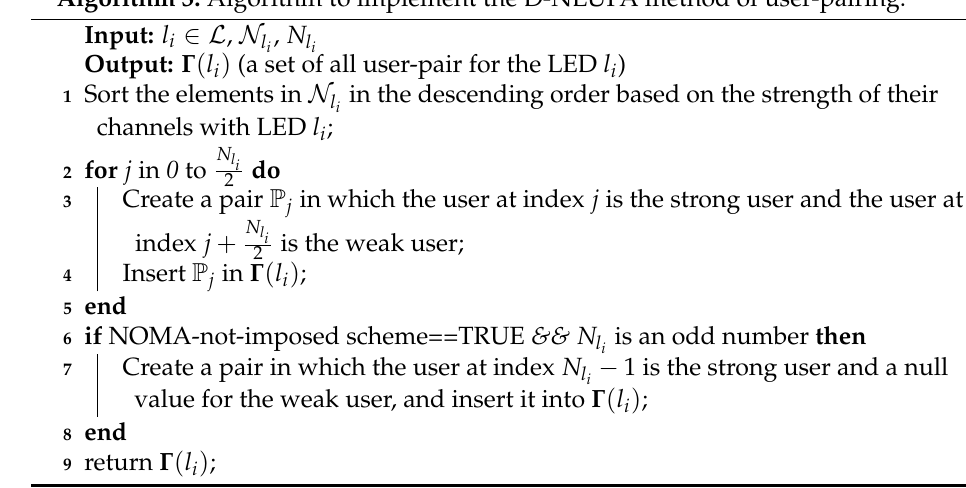
Algorithm 3: Algorithm to implement the D-NLUPA method of